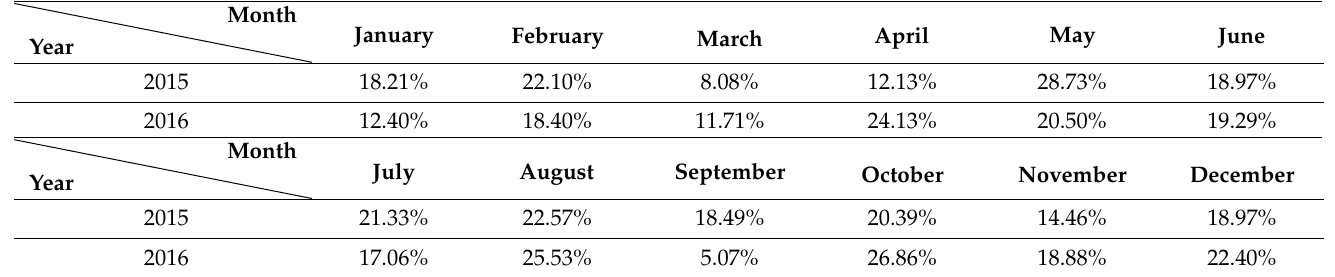
Table 6. The accuracy of the drought classification model in 12 months (Temperate Region of Australia Victoria).